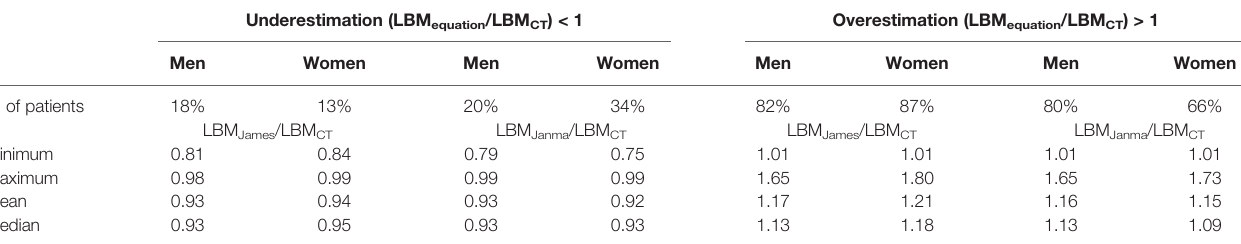
TABLE 2 | Overestimation and underestimation of lean body mass (LBM) by the use of equations.